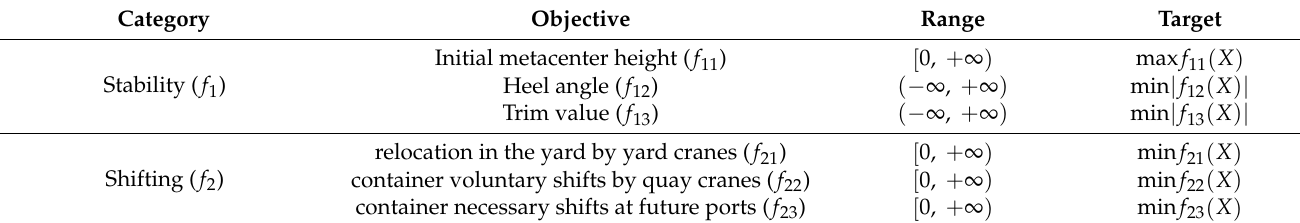
Table 2. The specific meaning of the six objective functions of the